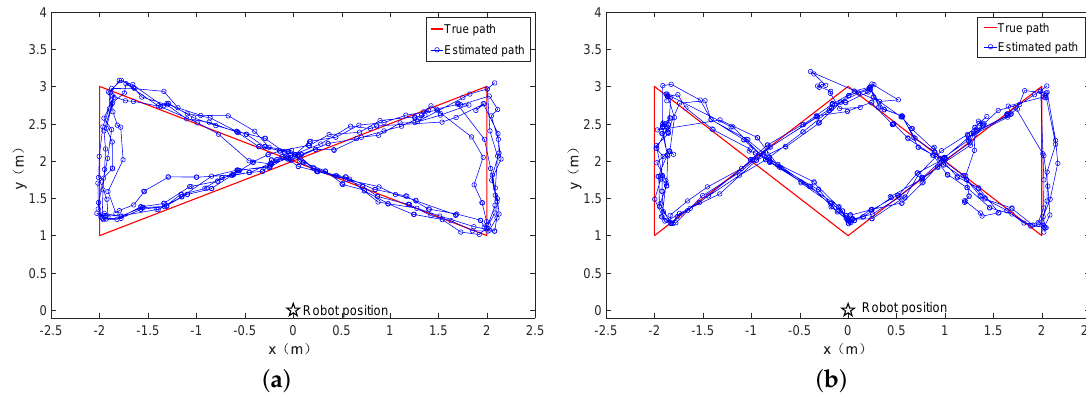
Figure 7. Complex paths. ( a ) 8-shaped path; ( b ) W-shaped path.